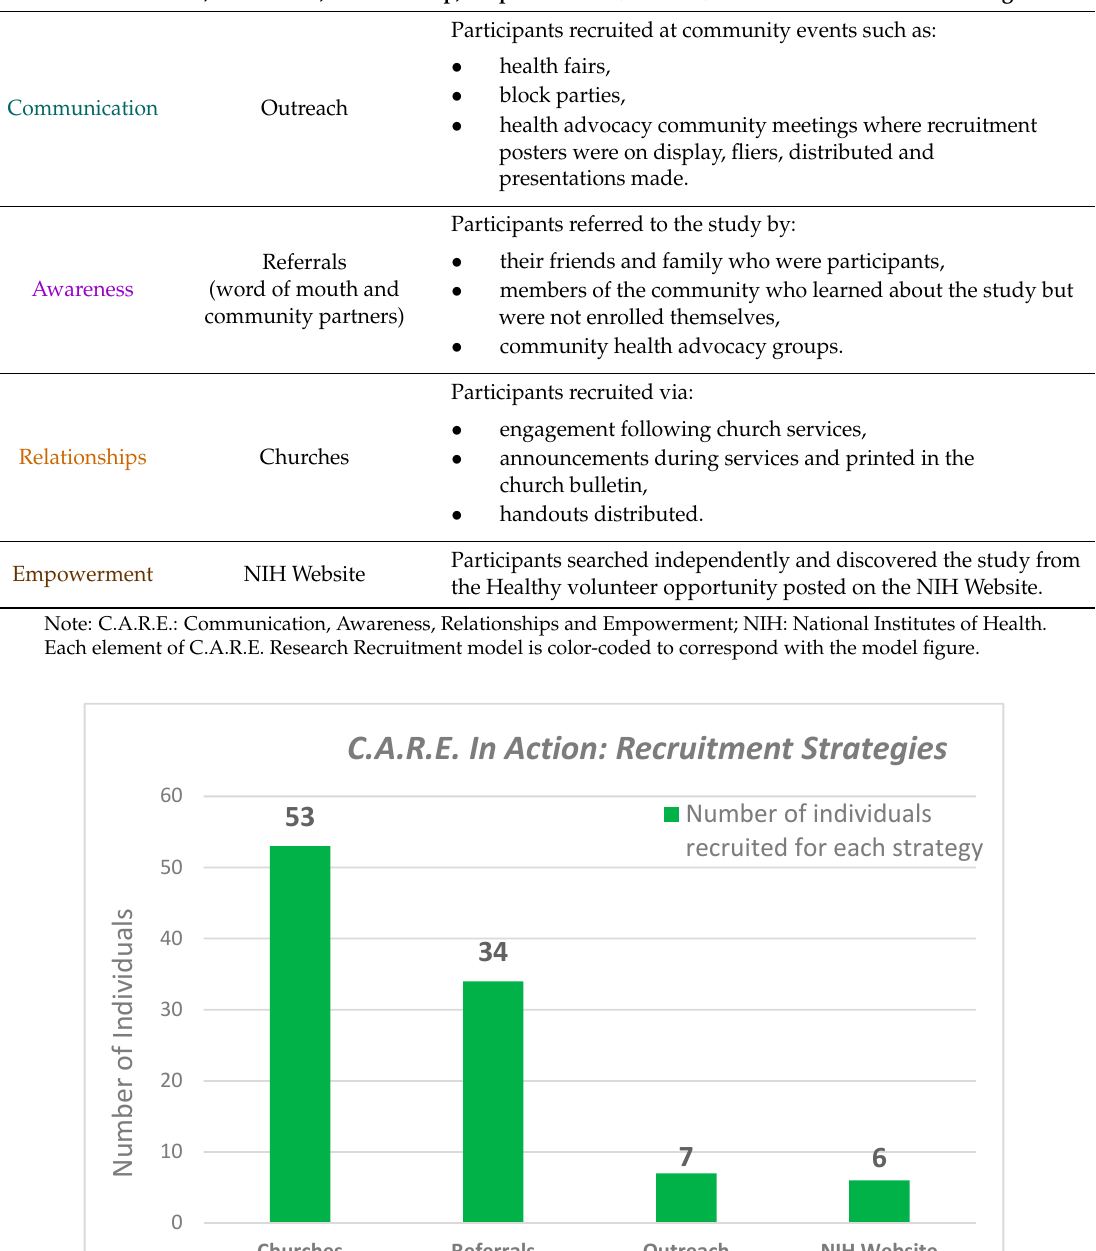
Table 1. C.A.R.E. Recruitment Strategies. C.A.R.E. recruitment strategies included capitalizing on church partnerships, encouraging referrals and outreach, and posting on the NIH website.